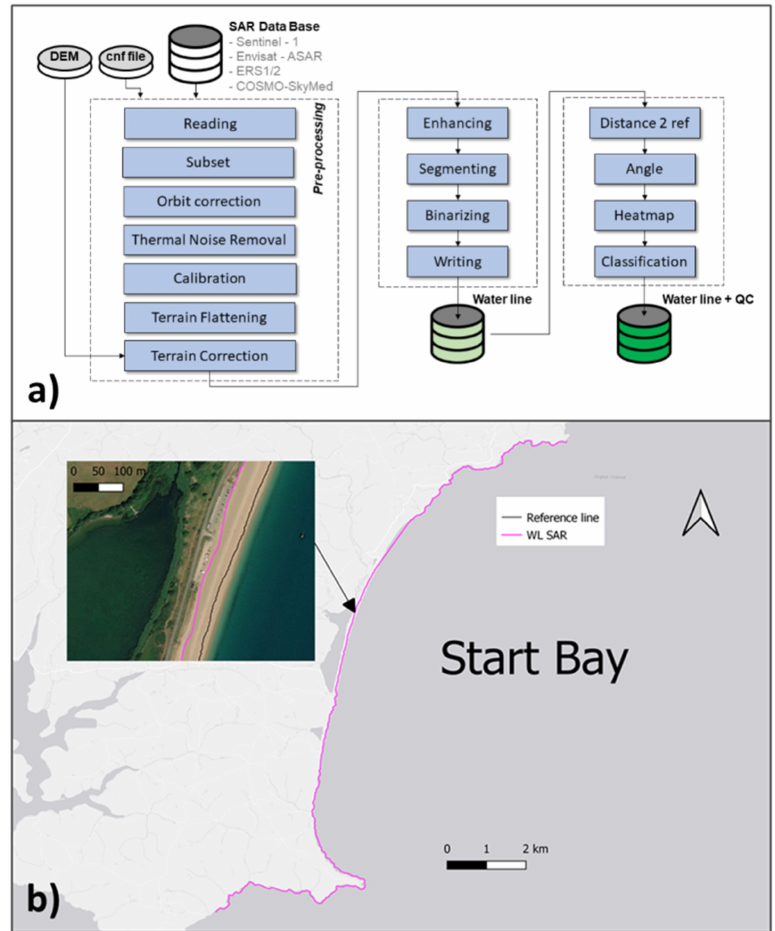
Figure 3. ( a ) SAR Waterline Processing workflow; ( b ) example of WL (magenta line) derived from SAR data (Sentinel-1) for Start Bay. Shown also is the reference line used by the service provider (isardSAT Ltd.) to assess the quality of the line. Source of aerial imagery: Esri, Maxar, GeoEye, Earthstar Geographics, CNES/Airbus DS, USDA, USGS, AeroGRID, IGN, and the GIS User Community, v10.6. Source of Light Gray Canvas Base map: Esri, HERE, Garmin, © OpenStreetMap contributors, and the GIS user